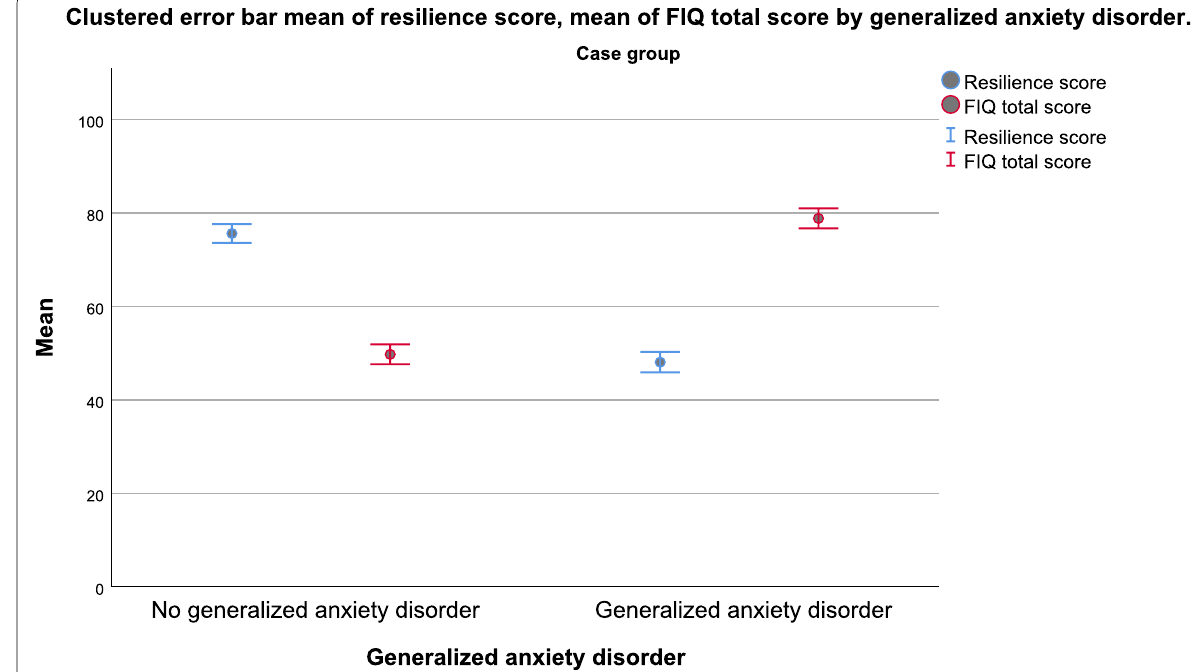
Fig. 2 Bar graph showing that fibromyalgia patients with a generalized anxiety disorder had low resilience and higher disease severity in comparison to those without generalized anxiety disorder using the Kruskal-Wallis test ( P